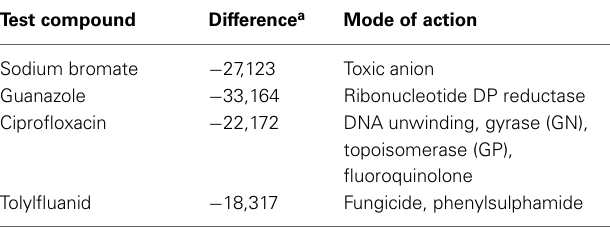
Table 5 | Comparison of the differential phenotypes expressed by C. sakazakii SP291 and C. sakazakii ATCC BAA-894 related